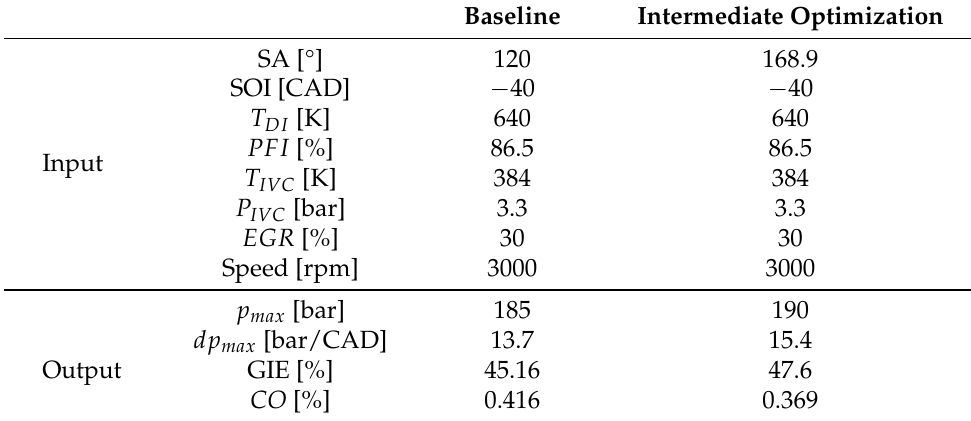
Table 6. Operating condition and performance parameter of the baseline case and intermediate opti- mization.